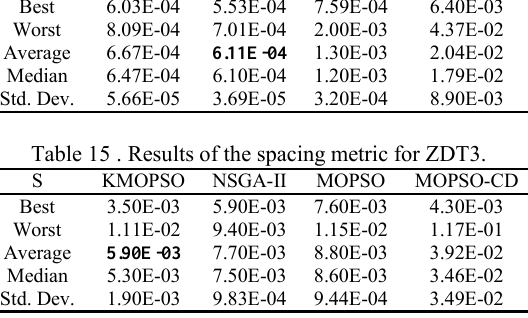
Table 13 . Results of the maximum spread metric for ZDT1. KMOPSO NSGA-II MOPSO